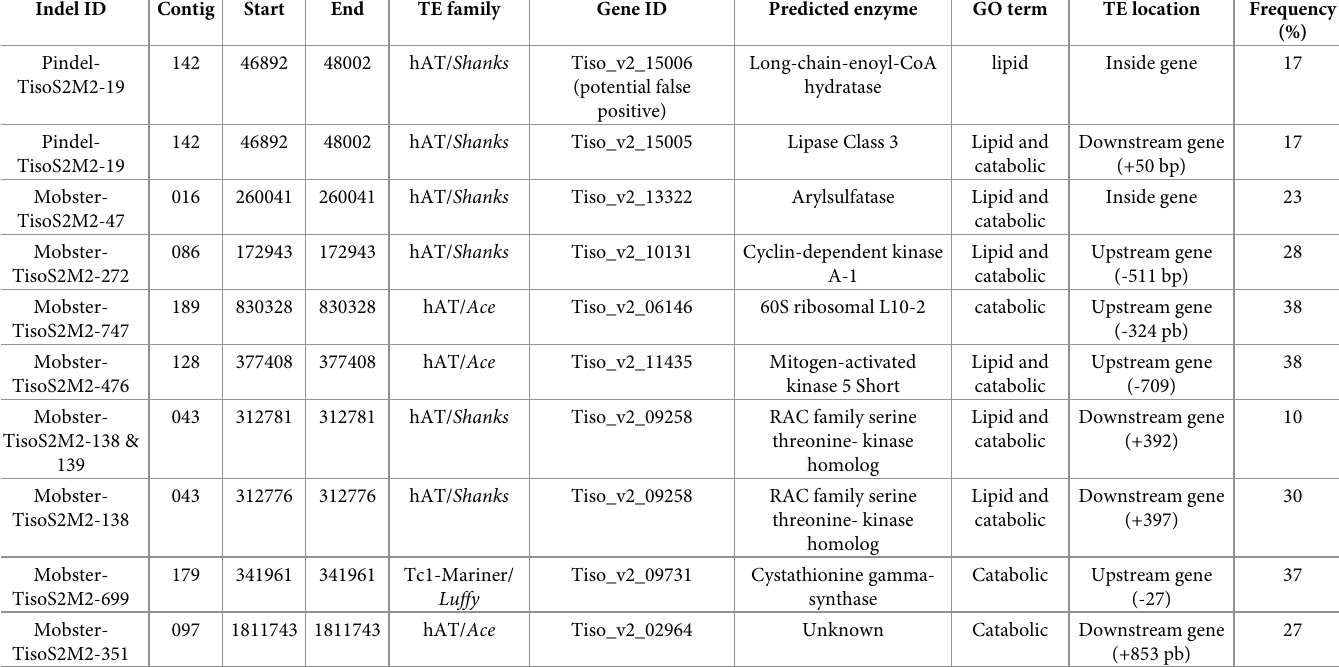
Table 1. Specific TE indels of TisoS2M2 located close to or within genes involved in lipid or catabolic metabolism. The frequencies of the insertion and deletion events were measured by Mobster and Pindel, respectively. Indel